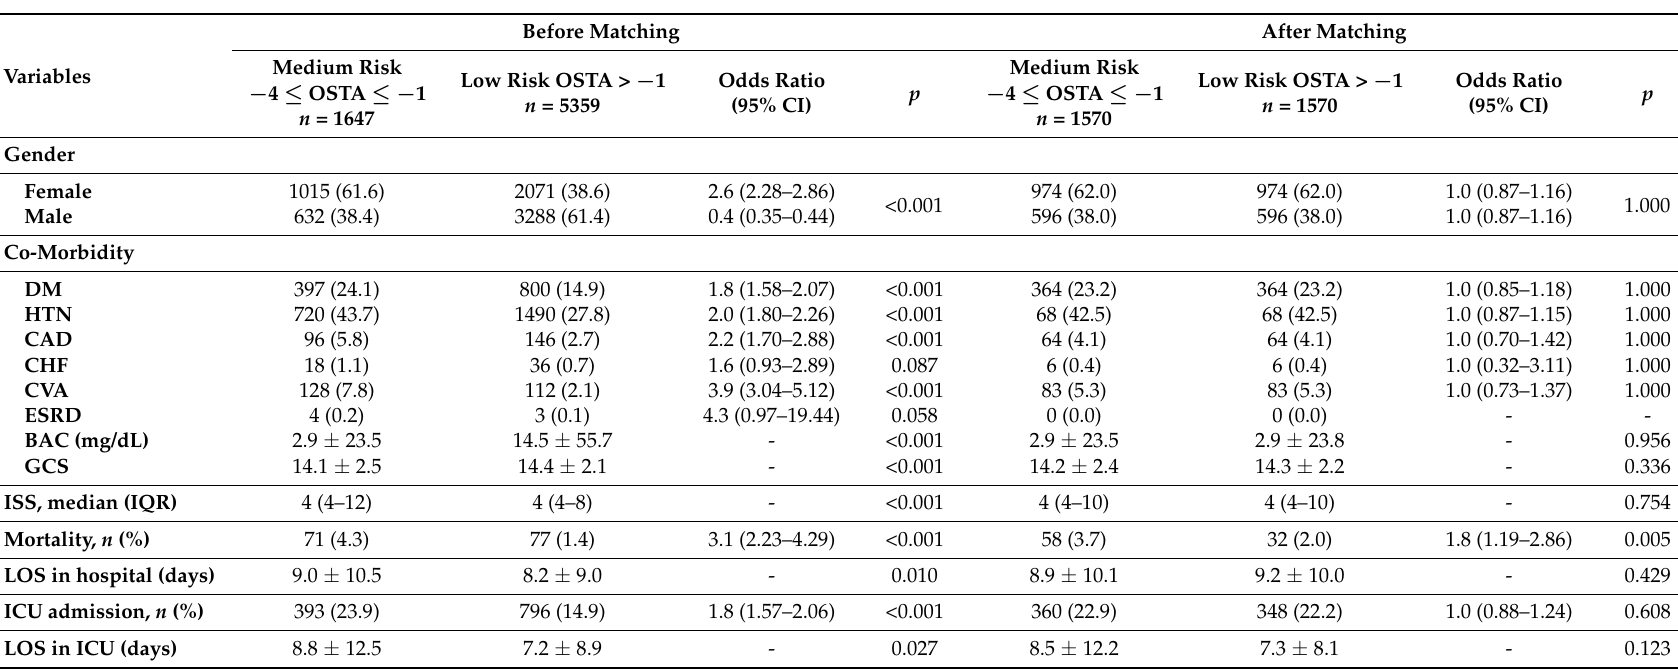
Table 4. Outcome of medium-risk and low-risk patients before and after propensity score-matching with adjustment of the covariates including gender, co-morbidity, BAC, GCS, and